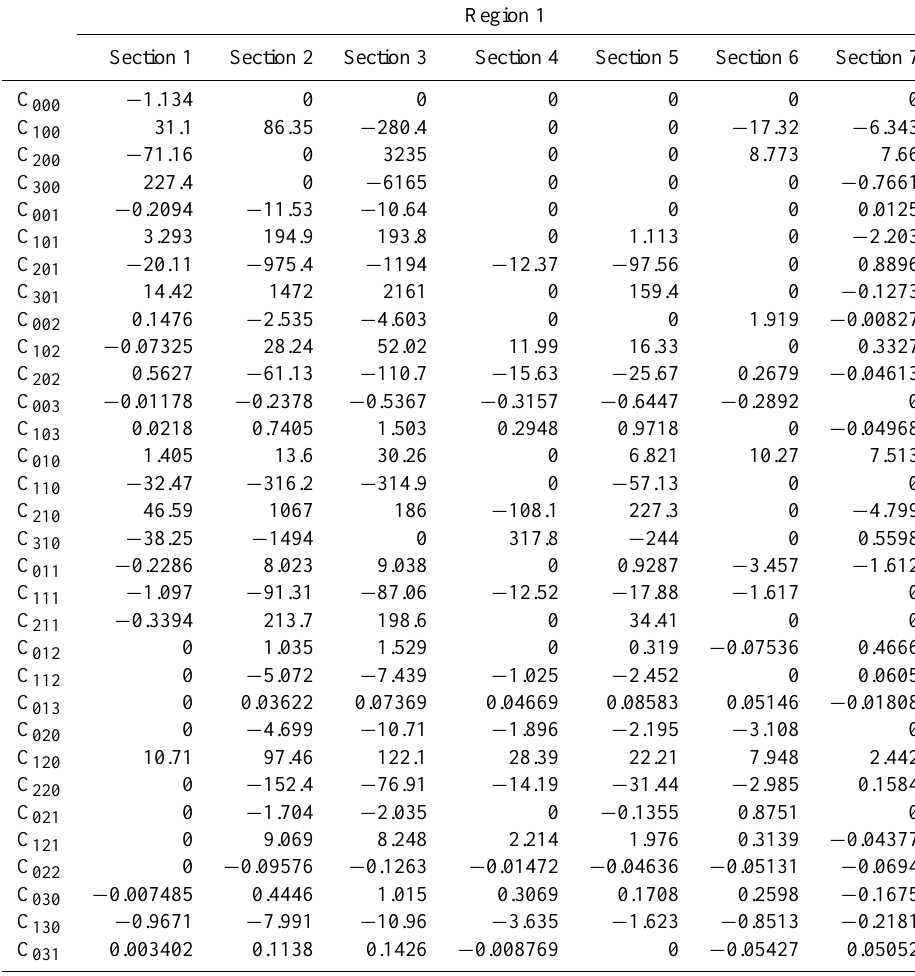
Table 3. The coefficients of Eq. (23) for region